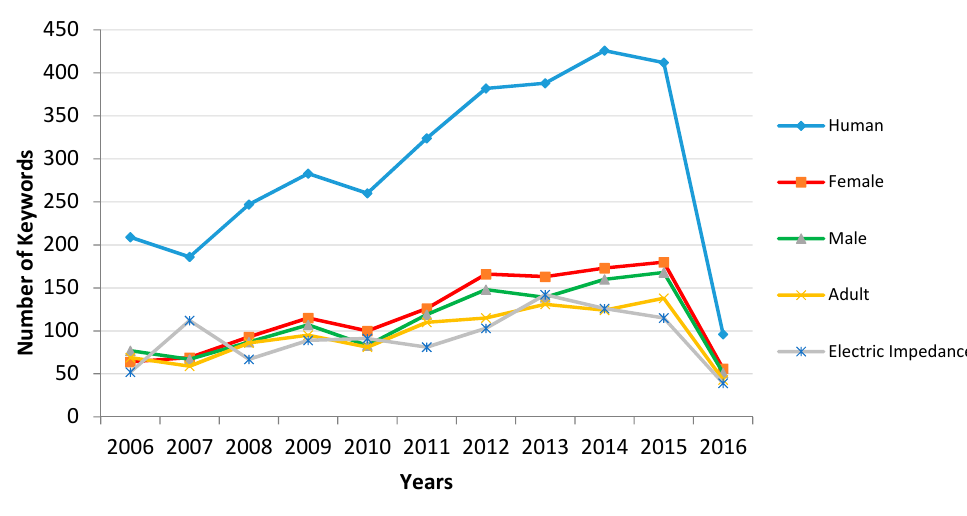
Figure 12. Evolution of the top 5 keywords in “dielectric” in the last 10 years.